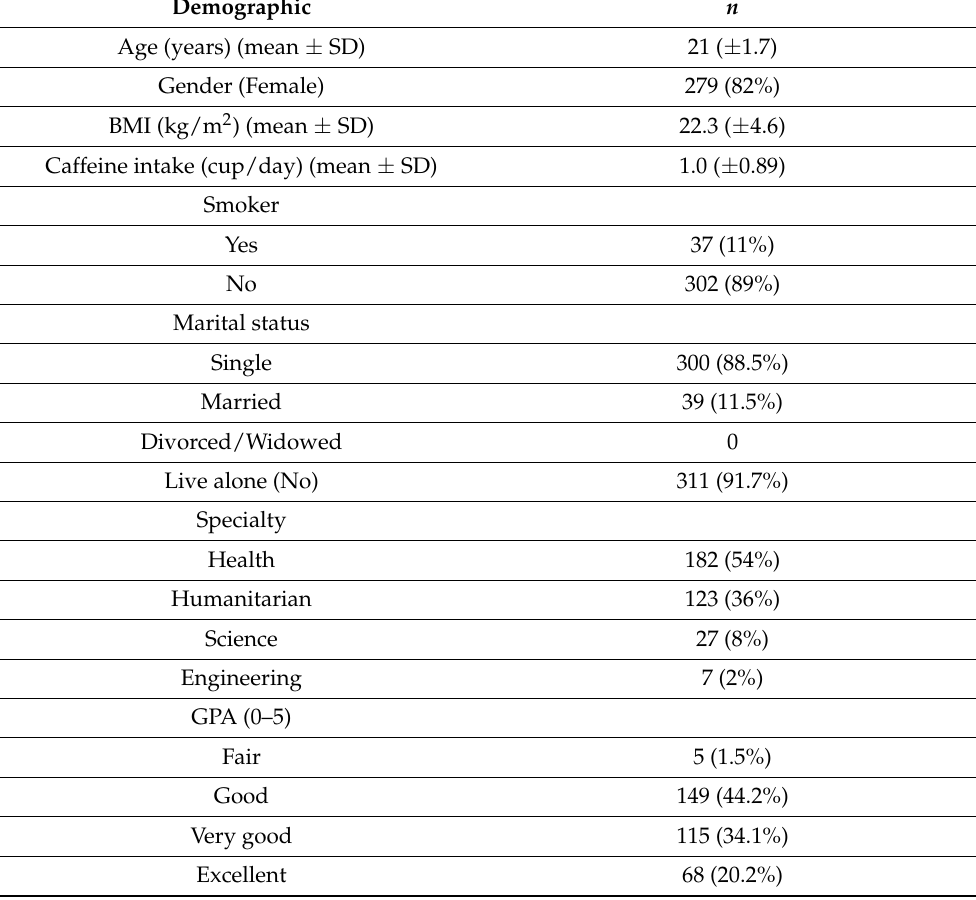
Table 1. Demographic information of the